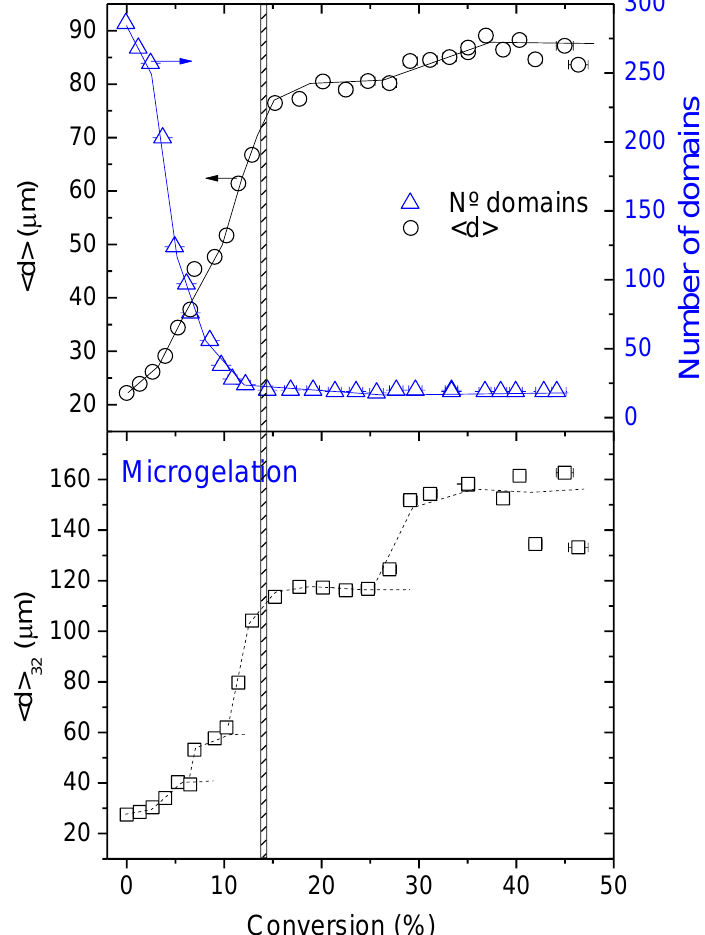
Figure 5. Domain average diameter (< 𝑑 >) , number of PAMS-rich domains, and third moment of the domain diameter distribution (< 𝑑 > 32 ) as a function of epoxy conversion for the system HDGEBA/PAMS at 40 °C. Lines are eye-guides.